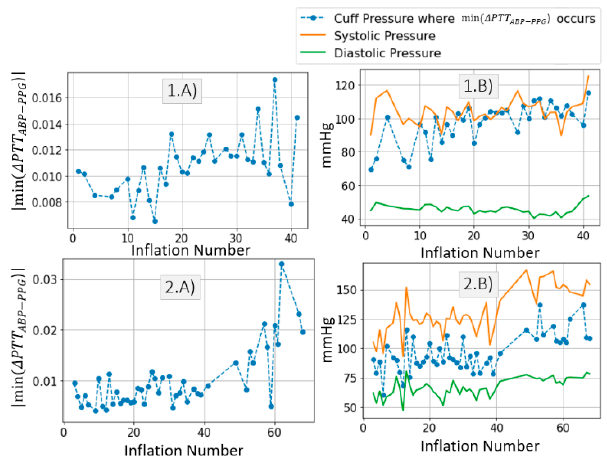
Figure 7. ( A ) Maximum drop in ∆ PTT ABP − PPG per inflation. ( B ) Cuff pressure at which the maxi- mum drop in ∆ PTT ABP − PPG occurs, systolic and diastolic systemic values per inflation. Results are displayed for Patient 1 data and Patient 2 data respectively. Expected ∆ PTT distal is twice the value of ∆ PTT ABP − PPG